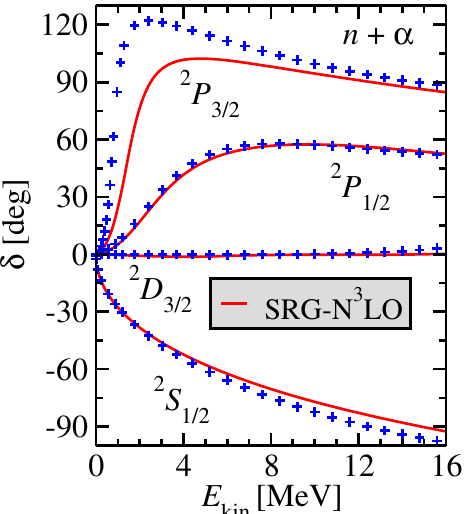
(cid:41)(cid:76)(cid:74)(cid:17) (cid:20)(cid:20)(cid:17) Calculated n - α phase shifts obtained in a N max = 17 model space, including g.s. and 0 + 0 states of 4 He, for the SRG- N 3 LO [44] NN potential at (cid:2) Ω = 20 MeV, compared to an R - matrix analysis of data ( + ) [43].